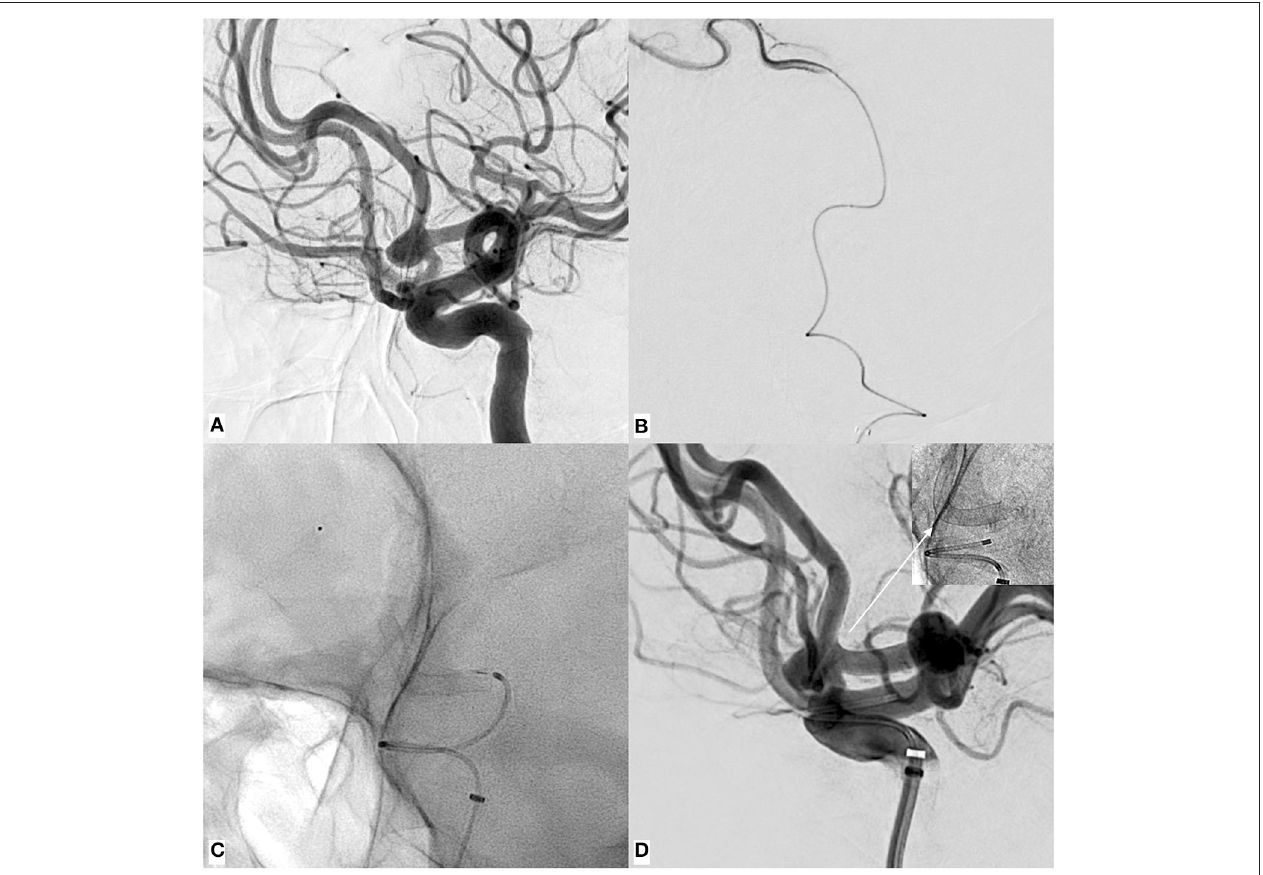
FIGURE 1 | An example of p48MW hydrophilic coating (HPC) implantation for treatment of an un-ruptured, broad-based aneurysm of the AcomA complex via the left internal carotid artery (ICA). (A) Digital subtraction angiography (DSA) run in working projection revealing the broad based (neck: 5.3 mm), saccular aneurysm (fundus: 5.2 × 4.3 mm) predominantly filled by the left anterior cerebral artery (ACA). (B) Catheterization of the elongated, demanding ACA using the Excelsior SL 10 and confirmation of the correct endoluminal position distal to the aneurysm as a pre-requisite for safe microcatheter exchange/introduction of the Prowler Select Plus required for device delivery. (C) Plain radiography in working projection demonstrating flow diverter stent (FDS) implantation—note the radiopaque olive tip at the distal end of the p48 wire at the level of the distal A2 segment, which helped to stabilize the equipment during deployment. Implantation of the device has caused